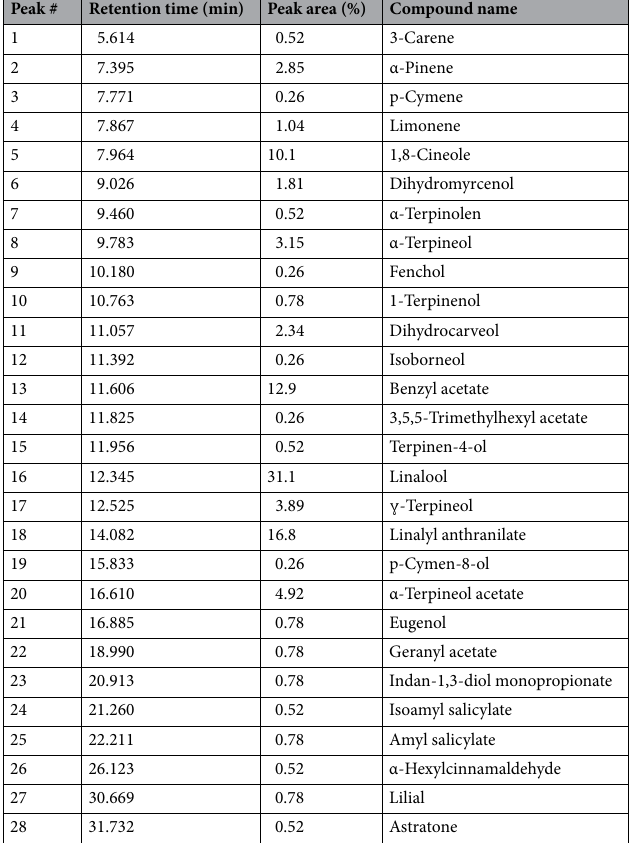
the EO concentration at 30 and 45 dap.